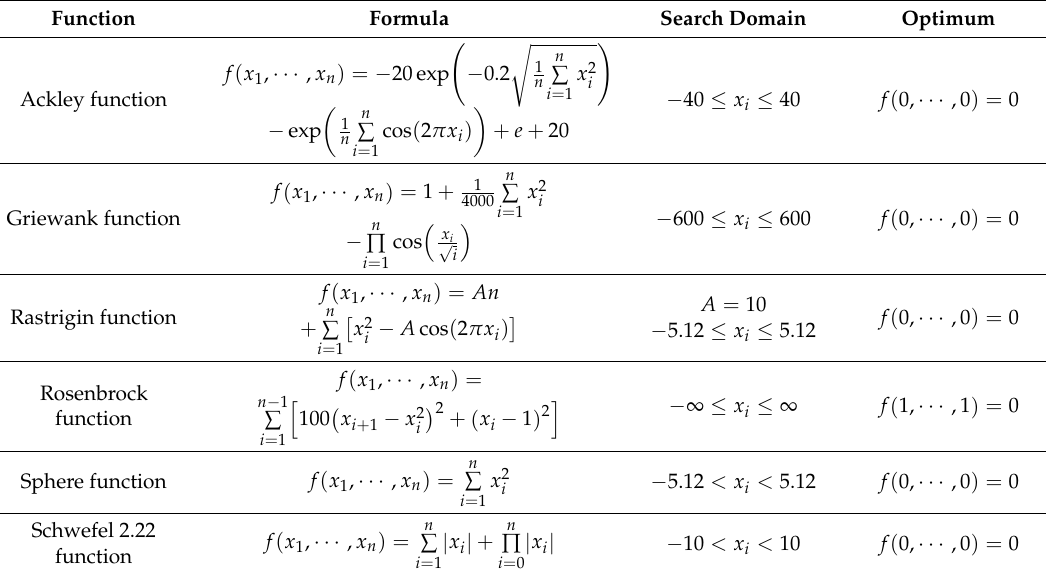
Table 1. Test functions.